Question: Write a caption explaining this figure to a reader.
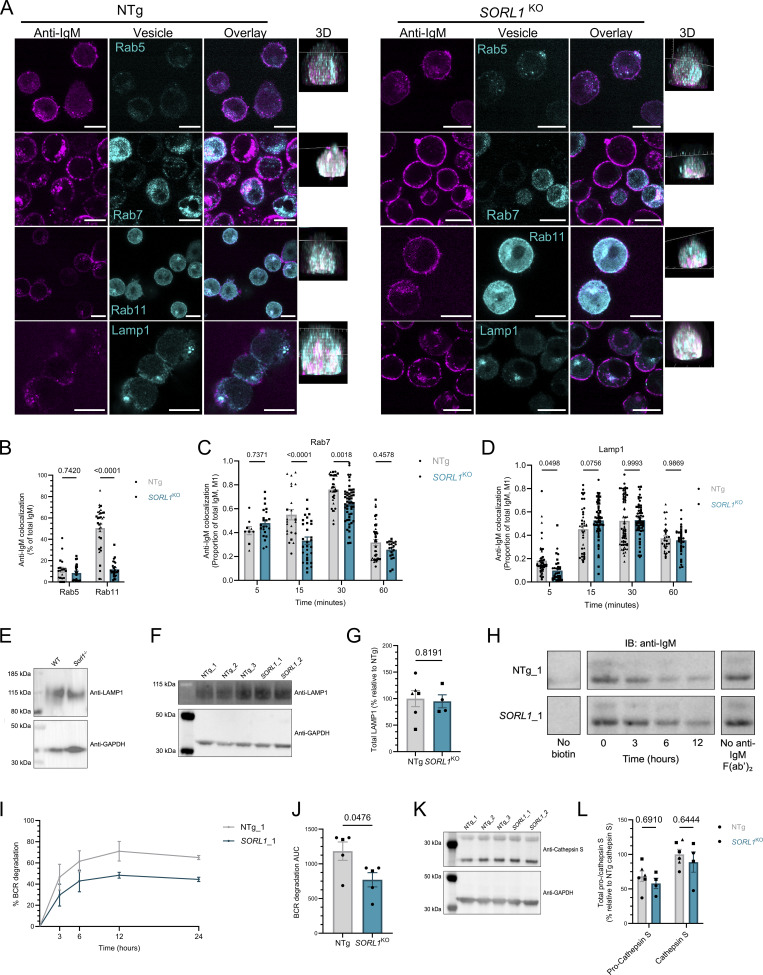
Answer: SorLA regulates antigen-induced BCR degradation in Ramos-Cas9 cells. (A) Representative confocal micrographs of anti-IgM surrogate antigen (magenta) and distinct vesicle markers (cyan) following 15-min incubation at 37°C. 100× magnification. Images show individual fluorescent channels and an overlay from a single z-stack slice (ImageJ). 3D column shows a 3D projection of the overlay z-stack (Imaris). Colocalization appears white. Scale bars = 10 µm. (B) Quantification of anti-IgM colocalization with organelle markers in NTg and SORL1 KO Ramos-Cas9 cell lines following surrogate antigen stimulation for 15 min. Manders’ coefficient. Rab5: n = 20–23 cells, Rab11: n = 25–33 cells. Three independent experiments. (C) Quantification of anti-IgM colocalization with Rab7 in NTg and SORL1 KO Ramos-Cas9 cell lines following surrogate antigen stimulation for indicated times. Manders’ coefficient. n = 9–51 cells in three independent experiments. (D) Quantification of anti-IgM colocalization with LAMP1 in NTg and SORL1 KO Ramos-Cas9 cell lines following surrogate antigen stimulation for indicated times. Voxel-based Manders’ coefficient. n = 29–68 cells in three independent experiments. (E) Representative immunoblot showing total LAMP1 expression in WT and SORL1 KO mouse splenic B cells. GAPDH used as protein-loading control. (F) Representative immunoblot showing total LAMP1 expression in NTg and SORL1 KO Ramos-Cas9 cell lines. GAPDH used as protein-loading control. (G) Densitometry quantification of total LAMP1 expression in NTg and SORL1 KO Ramos cell lines. n = 4–6 independent Ramos-Cas9 transductions with three NTg sgRNAs and two SORL1 -targeting sgRNAs (indicated by different symbols) quantified from two immunoblots. P values shown are calculated by unpaired t test. (H) Representative immunoblot showing BCR degradation in NTg and SORL1 KO Ramos-Cas9 cell lines over 12 h following surrogate antigen stimulation. No biotin and no anti-IgM controls are included at 6 h. (I) % BCR